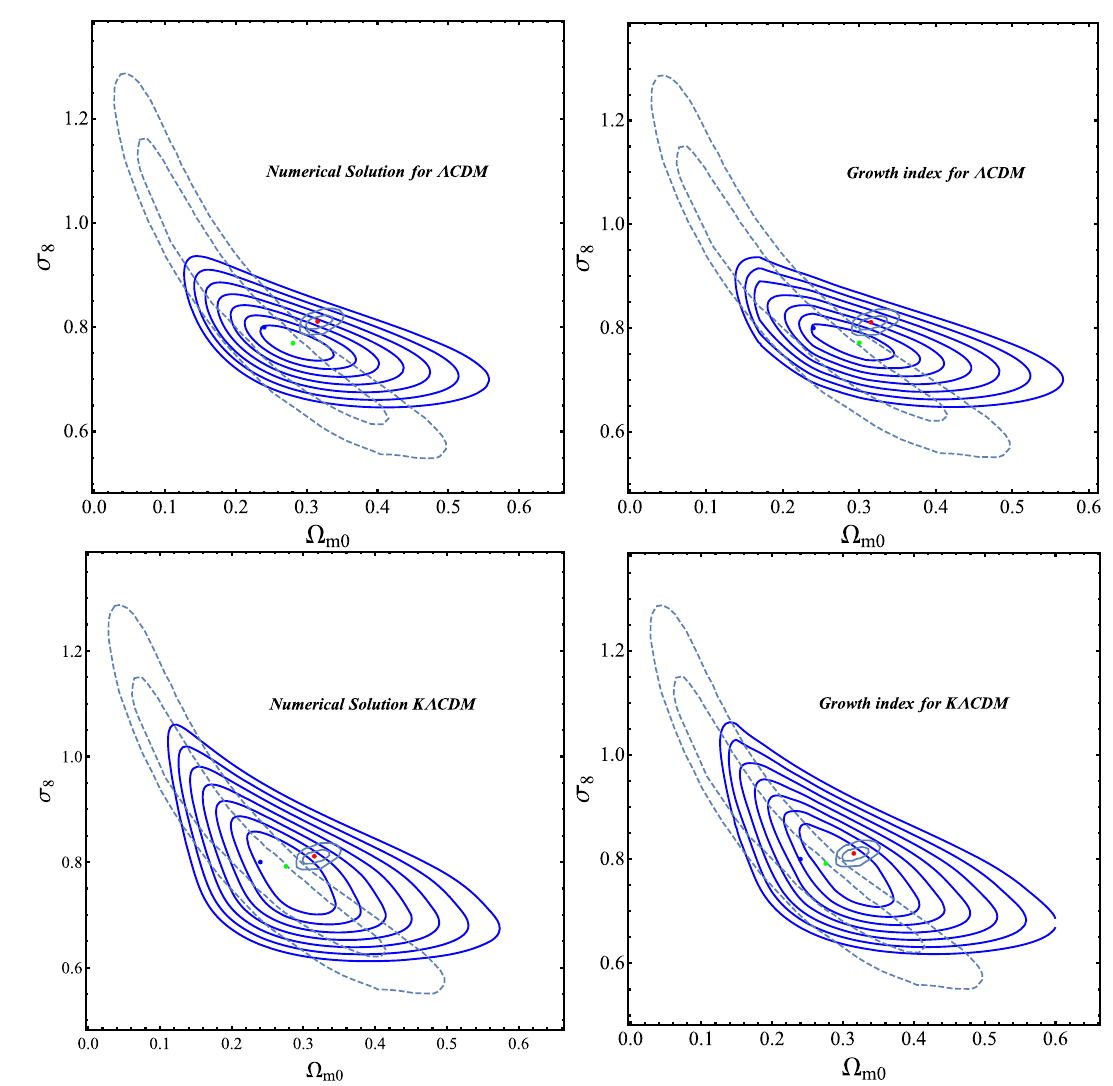
Fig. 1 In the top, we can see observational constraints on the flat (cid:5) CDM model. In the bottom, we see the observational constraints on the non-flat (cid:5) CDM model. The (cid:3) k 0 parameter was marginalized in